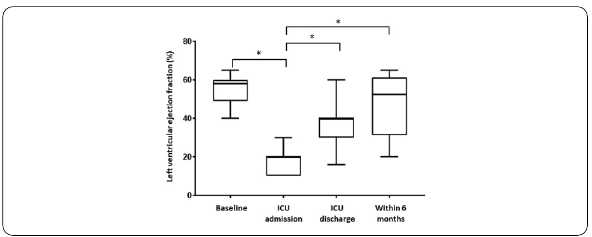
Figure 1. Evolution of left ventricular ejection fraction (%): at baseline, at ICU admission and discharge and within 6 months post-ICU discharge in ICU-survivors. *p <